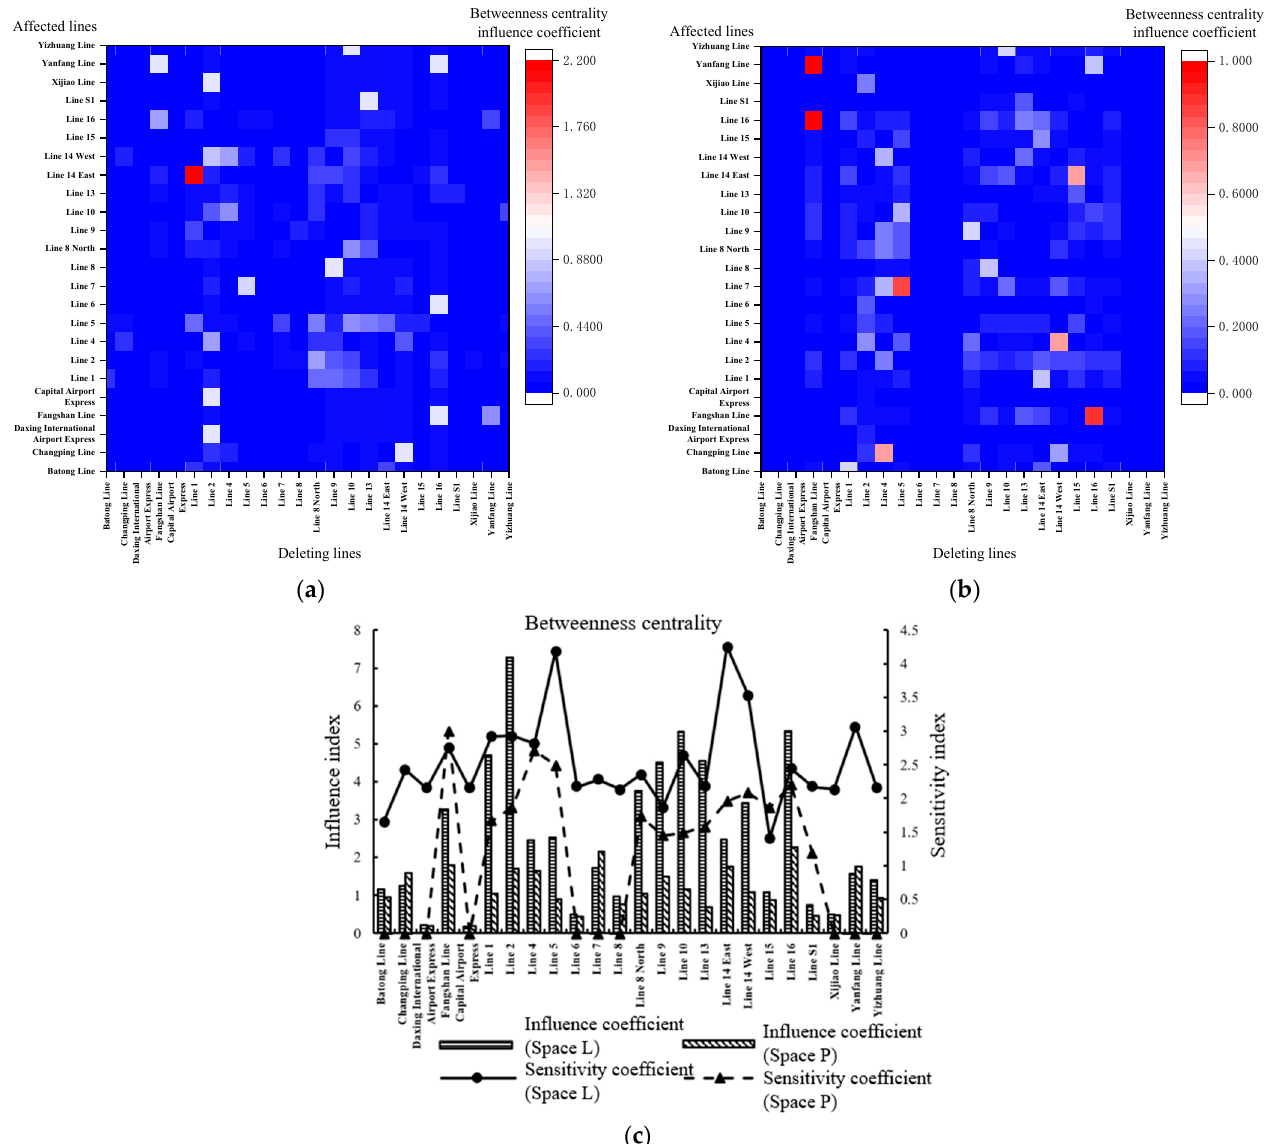
Figure 10. Intermediate centrality influence and sensitivity coefficient between lines. ( a ) Intermediate centrality influence coefficient between lines (Space L). ( b ) Betweenness influence coefficient between lines (Space P). ( c ) Intermediate centrality influence and sensitivity coefficient.